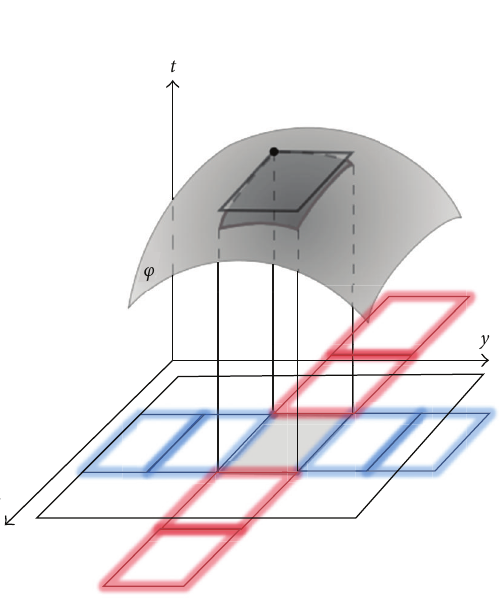
Figure 3: 4th-degree shape